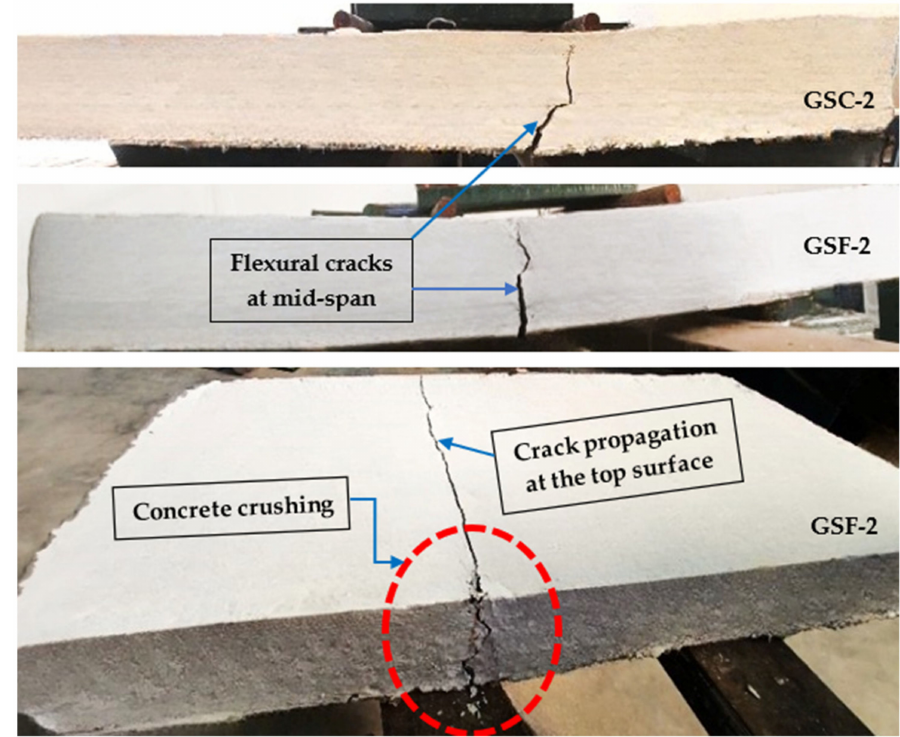
Figure 5. Crack propagation and failure mode of Mode-II slab specimens.